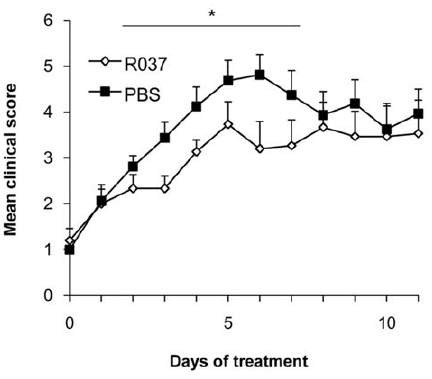
Figure 5. R037 relieves EAE severity in a therapeutic manner. R037 (0.8 mg/ml; n=16) or PBS (n=17; control) were administered in a water bottle to C57BL/6 mice from 11 days after immunization with MOG 35–55 . The area under the curve (AUC) under the bar was significantly lower in R037-treated mice. Data represent mean score + SEM of two independent experiments. *p # 0.05.